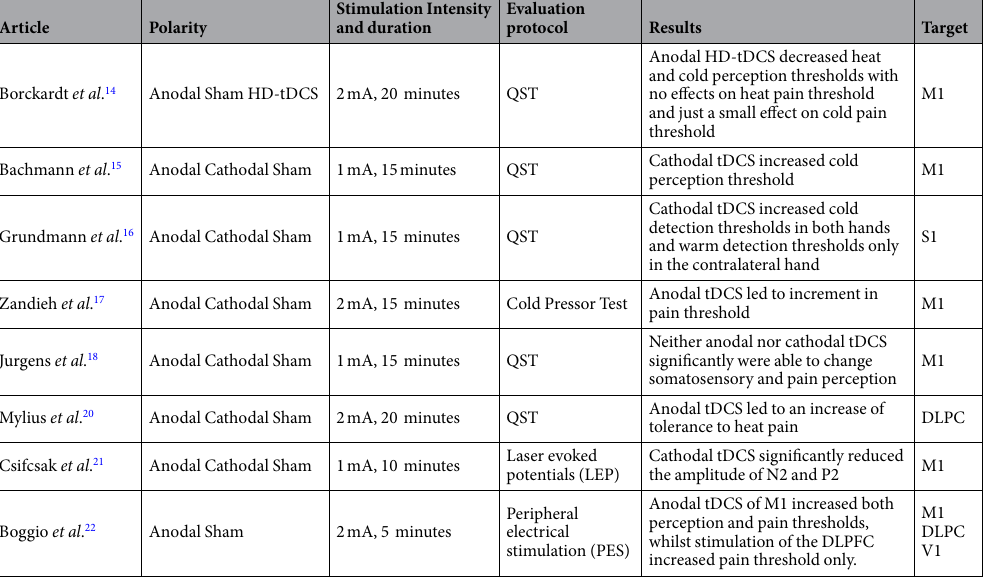
Table 1. Most relevant papers about the effects of tDCS on temperature and pain perception in healthy